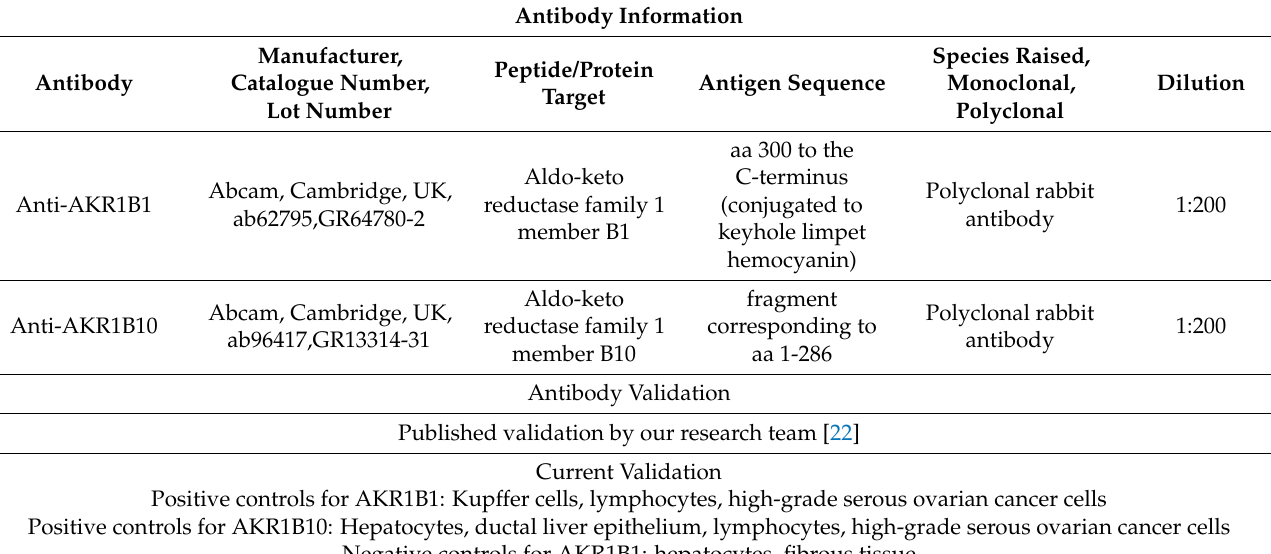
Table 2. Antibody description and